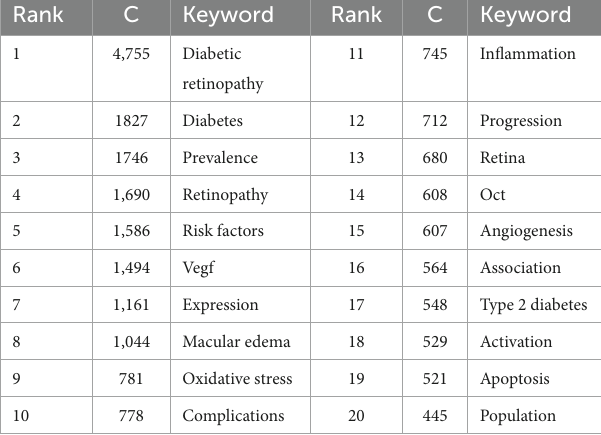
TABLE 5 Top 20 keywords with frequency detected by